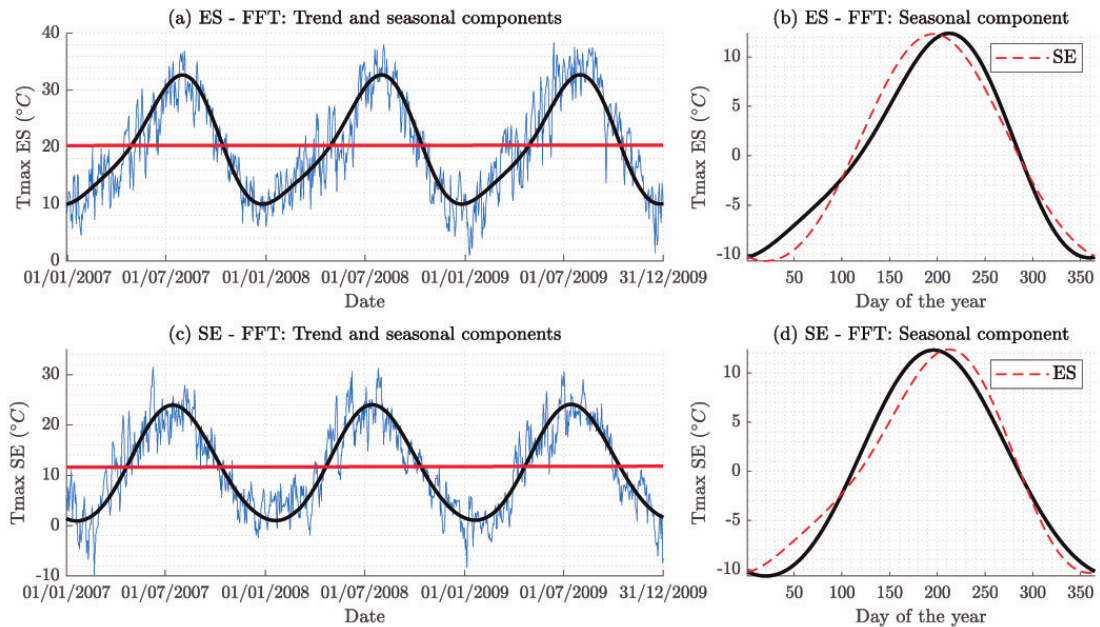
Figure 4. Trend and seasonal components estimated by the FFT model for ( a ) Spain (ES), and ( c ) Sweden (SE). ( b ) and ( d ) show the detail of the seasonal component estimated for each country. In order to facilitate the comparison between both countries, seasonal components of ( b ) Sweden and ( d ) Spain are indicated with red broken